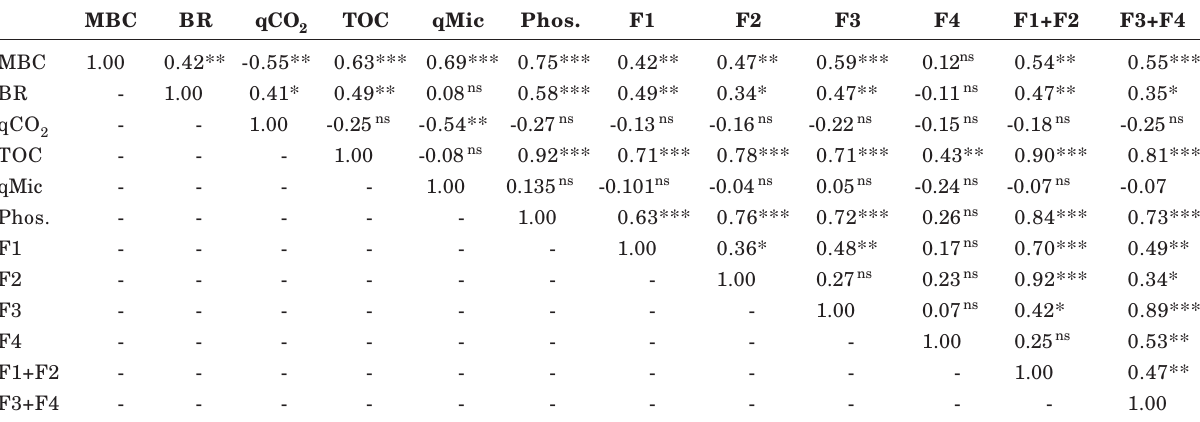
Table 6. Pearson bivariate correlation between variables of a dystrophic Red Latossol under coffee with three split P applications, two irrigation regimes and two soil layers TOC qMic Phos.